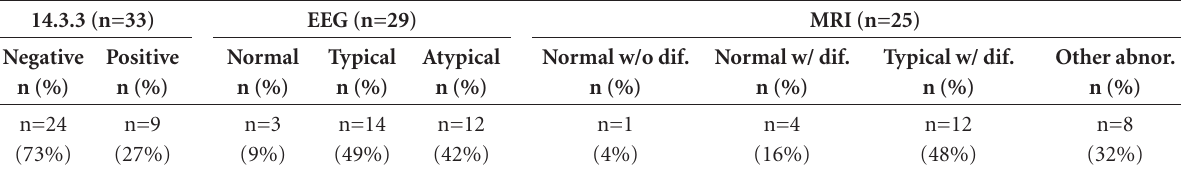
Table 3. Diagnostic approaches performed in the notified